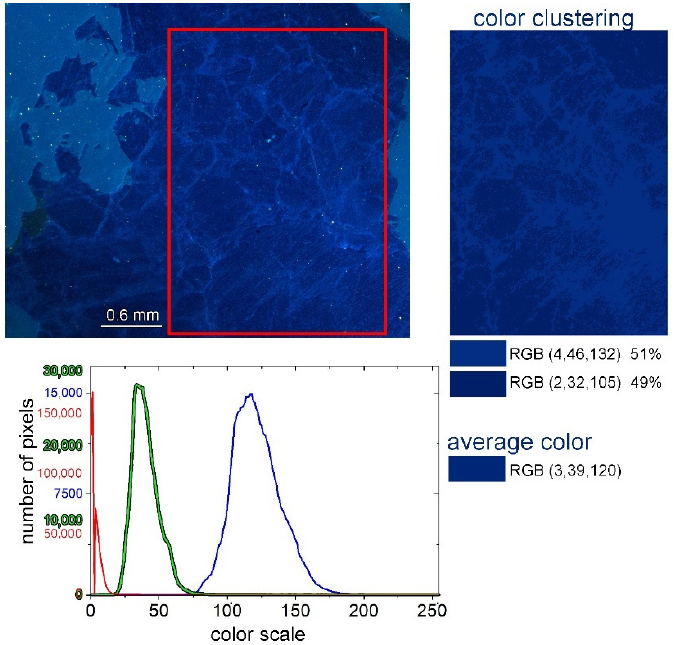
Figure 3. Example of data treatment performed on petrographic CL images. The original image (corresponding to a sample of fragment 33abc) was cropped (red rectangle) and, from it, several data were obtained: histograms for the three color-channels; a simplified version of the image in which colors have been clustered into a few pixel types identified by their RGB values and their abundance on the image; and the average RGB value of the image.